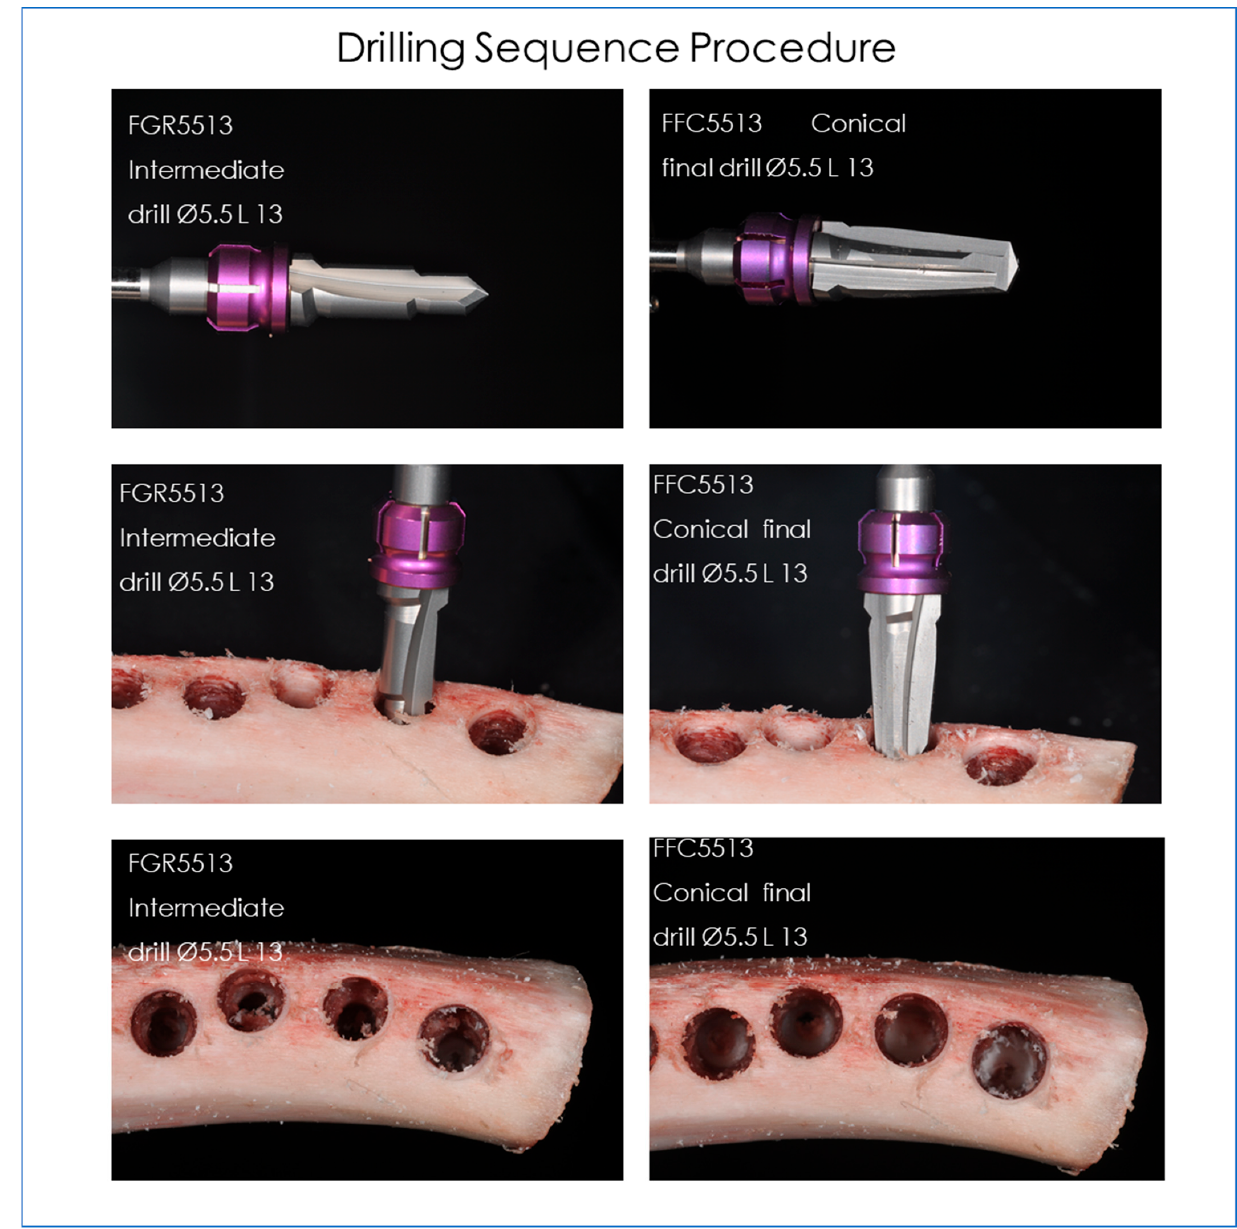
Figure 3. Details of the drilling sequence (continued) .